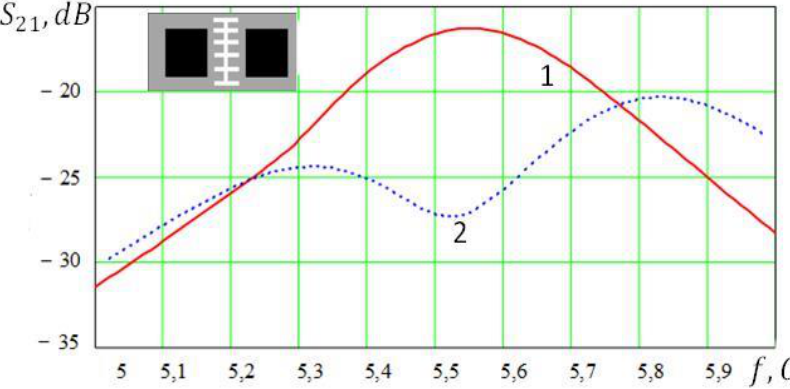
Fig. 6. Decoupling by the cutout in the form of a meander in the dielectric substrate: 1 – reference antenna; 2 – antenna with